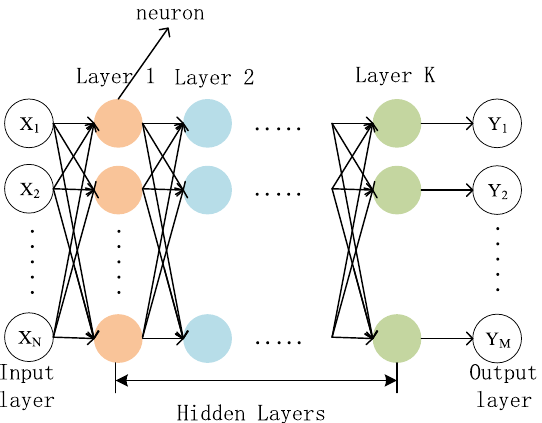
Fig. 1 Neuronal network architecture. It shows the result after multi-level operation of a neuronal network with hidden layers